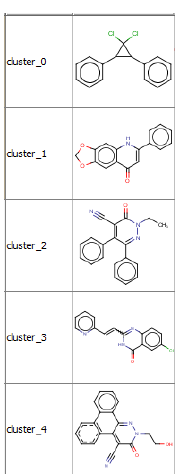
Fig. 16. The most common substructures of the five clus-